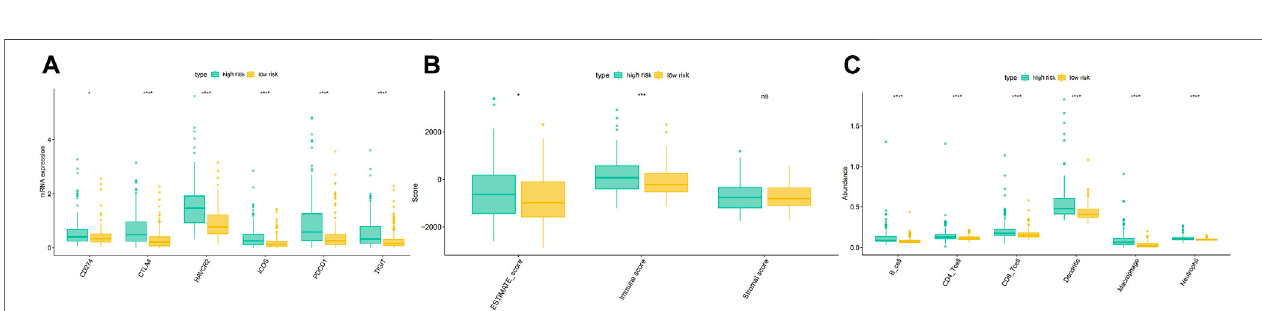
FIGURE 12 | Differences of the immune score, stromal score, ESTIMATE score (B) , immune cell (C) , and gene expression in immune checkpoints and T cell exhaustion (A) between high and low-risk groups in the TCGA dataset.